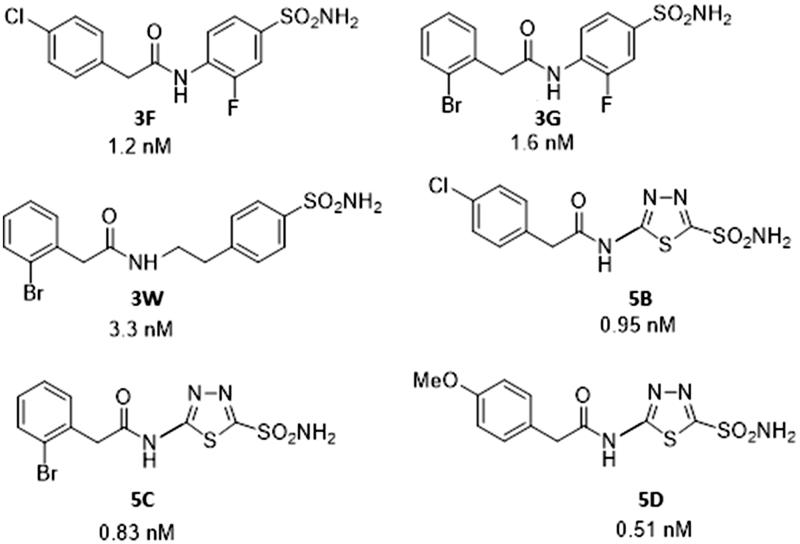
Sulfonamides 3F, 3G, 3W, 5B, 5C, and 5D used in the study and their TcCA inhibitory action.